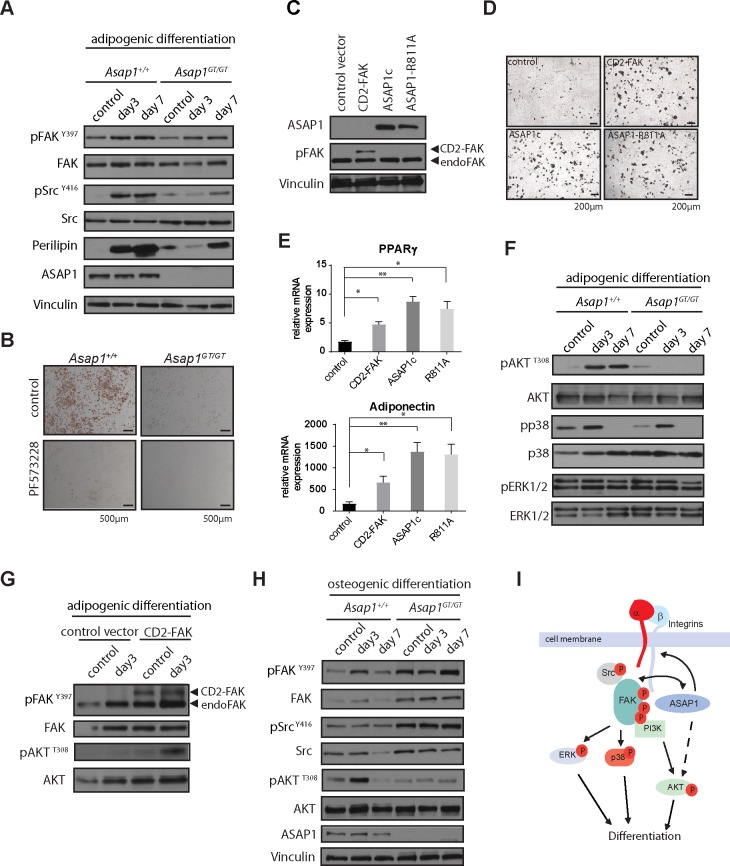
FAK/ Src and Akt signaling is impaired in Asap1GT/GT MEFs, which inhibits adipogenic differentiation.(A) FAK and Src phosphorylation is impaired when Asap1GT/GT MEFs are induced to differentiate into the adipogenic lineage. Protein lysates of undifferentiated controls and WT and Asap1GT/GT MEFs at day 3 and day 7 after induction of differentiation were analyzed by Western blotting. Blots were probed with the antibodies indicated on the left. (B) Inhibition of FAK activity by PF-573228 prevents adipogenesis in MEFs. WT and Asap1GT/GT MEFs were induced to differentiate into the adipogenic lineage with or without 10 μM PF-573228. Scale bars: 500 μm. (C) Asap1GT/GT MEFs were infected with control, CD2-FAK, ASAP1c or ASAP1-R811A retroviruses. Protein lysates of infected MEFs were analyzed by Western blotting. Blots were probed with the antibodies indicated on the left. (D) Enforced FAK activity in Asap1GT/GT MEFs rescues the induction of adipogenesis. Control Asap1GT/GT MEFs and Asap1GT/GT MEFs ectopically expressing CD2-FAK, ASAP1c or ASAP1-R811A were differentiated into the adipogenic lineage, and after seven days of differentiation they were stained with Oil Red O. Scale bars: 200 μm. (E) Control Asap1GT/GT MEFs and Asap1GT/GT MEFs ectopically expressing CD2-FAK, ASAP1c or ASAP1-R811A were differentiated into the adipogenic lineage. At adipogenic day 7, relative mRNA expression was analyzed for PPARγ and adiponectin, with normalization relative to the expression of RibP0. Data represent the mean ± SD. Significance was calculated using the Student’s t-test. *, p < 0.05, ** p < 0.01. (F) AKT signaling is abrogated when Asap1GT/GT MEFs are induced to differentiate. Protein lysates of undifferentiated controls and WT and Asap1GT/GT MEFs at day 3 and day 7 after induction of differentiation were analyzed by Western blotting. Blots were probed with the antibodies indicated on the left. (G) Constitutively active FAK induces AKT phosphorylation when Asap1GT/GT MEFs are induced to differentiate. Protein lysates of undifferentiated controls and Asap1GT/GT MEFs expressing empty control vector or CD2-FAK at day 3 after induction of adipogenic differentiation were analyzed by Western blotting. Blots were probed with the antibodies indicated on the left. (H) Src and AKT signaling is dysregulated when Asap1GT/GT MEFs are induced to differentiate into the osteogenic lineage. Protein lysates of undifferentiated controls and WT and Asap1GT/GT MEFs at day 3 and day 7 after induction of osteogenic differentiation were analyzed by Western blotting. Blots were probed with the antibodies indicated on the left. (I) Schematic model of ASAP1-dependent signaling during the differentiation of mesenchymal progenitor cells, proposed on the basis of the results in this paper and other observations in the literature. FAK activation by integrins leads to auto-phosphorylation of T397, a process regulated by ASAP1 through regulation of integrin recycling. T397 phosphorylation enables recruitment and activation of Src, leading to full activation of FAK, and binding of the PI3K regulatory subunit to FAK. ASAP1 regulates FAK/Src and AKT phosphorylation. Activation of the FAK/Src complex results in phosphorylation of down-stream signaling pathways including ERK, p38 and AKT, which in turn determine the differentiation fate of mesenchymal progenitor cells.